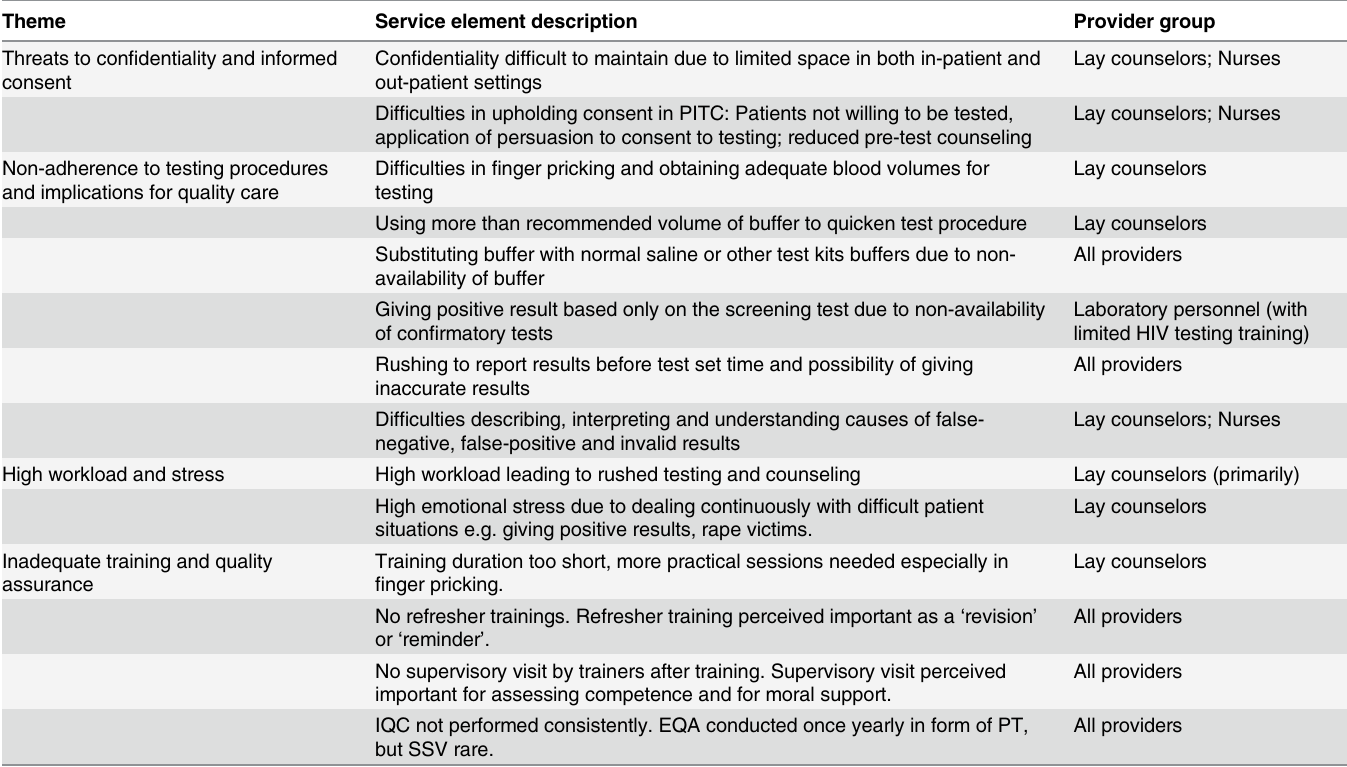
Table 2. Providers ’ experiences in HIV testing service provision and their understanding of elements impacting on